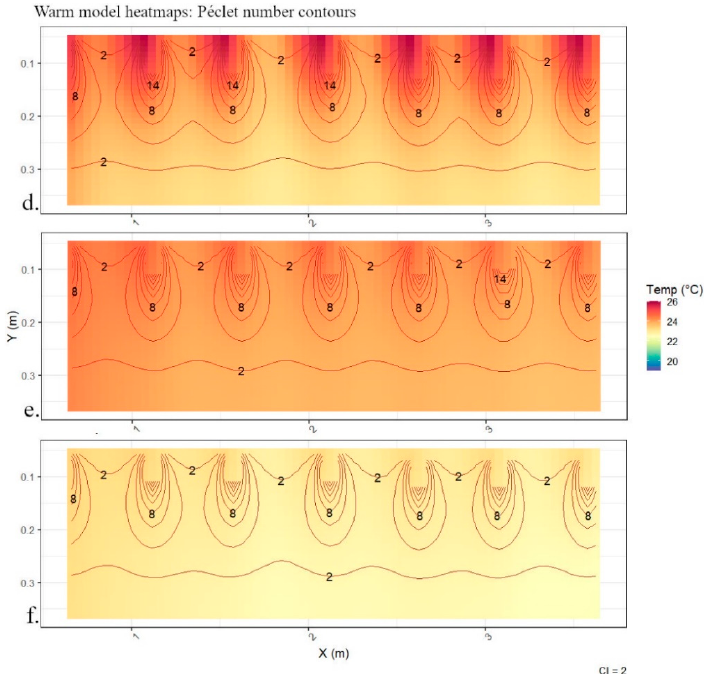
Figure 3. Temperature heat maps of cold runs ( a – c ) and hot runs ( d – f ) overlain with contours of Pe numbers with a contour interval of 2. Notice areas of highest Pe number are associated with temperature signatures of downwelling zones. Additionally, the shape of the contours is driven by the modeling software’s ‘step-down’ type gradient, and the actual contours would be more laterally continuous (see: Section 4.1).